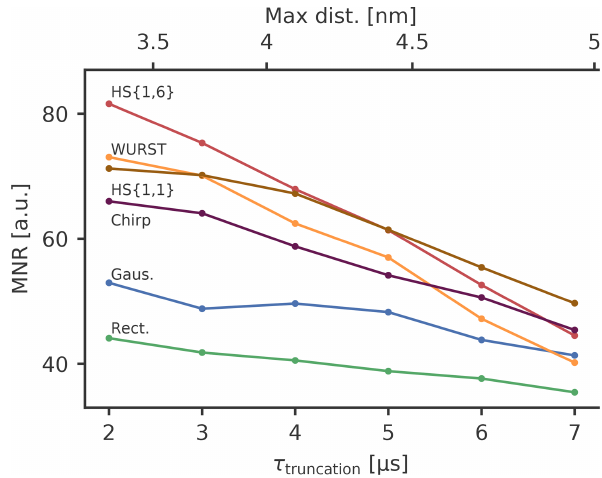
Figure 7. The MNR value as a function of the dipolar evolution time up to which the noise has been evaluated, i.e. the truncation time τ truncation . The sample has a concentration of 80µM of the spin-labelled ligand. The maximum distance according to Eq. (13) is depicted in the upper x axis. The line between the points is only a guide for the